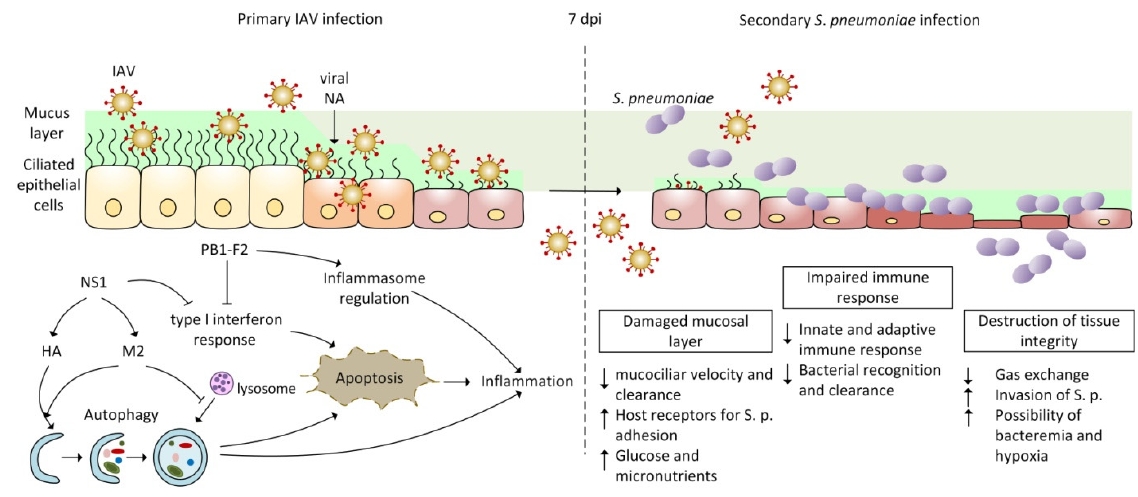
Figure 1. Illustration of influenza virus protein functions in the enhancement of S. pneumoniae lung infection. The mucosal layer in the lungs is damaged due to sialidase activity of viral NA, and ciliated epithelial cells in lungs, together with immune cells, are infected with IAV. During infection, IAV proteins PB1-F2, NS1, HA, NA, and M2 cause impairment of the immune response, the apoptosis and inflammation, leading to the destruction of tissue integrity. All of these viral protein functions can lead to enhanced susceptibility to secondary S. pneumoniae infection observed approximately 7 days after viral infection (7 dpi).